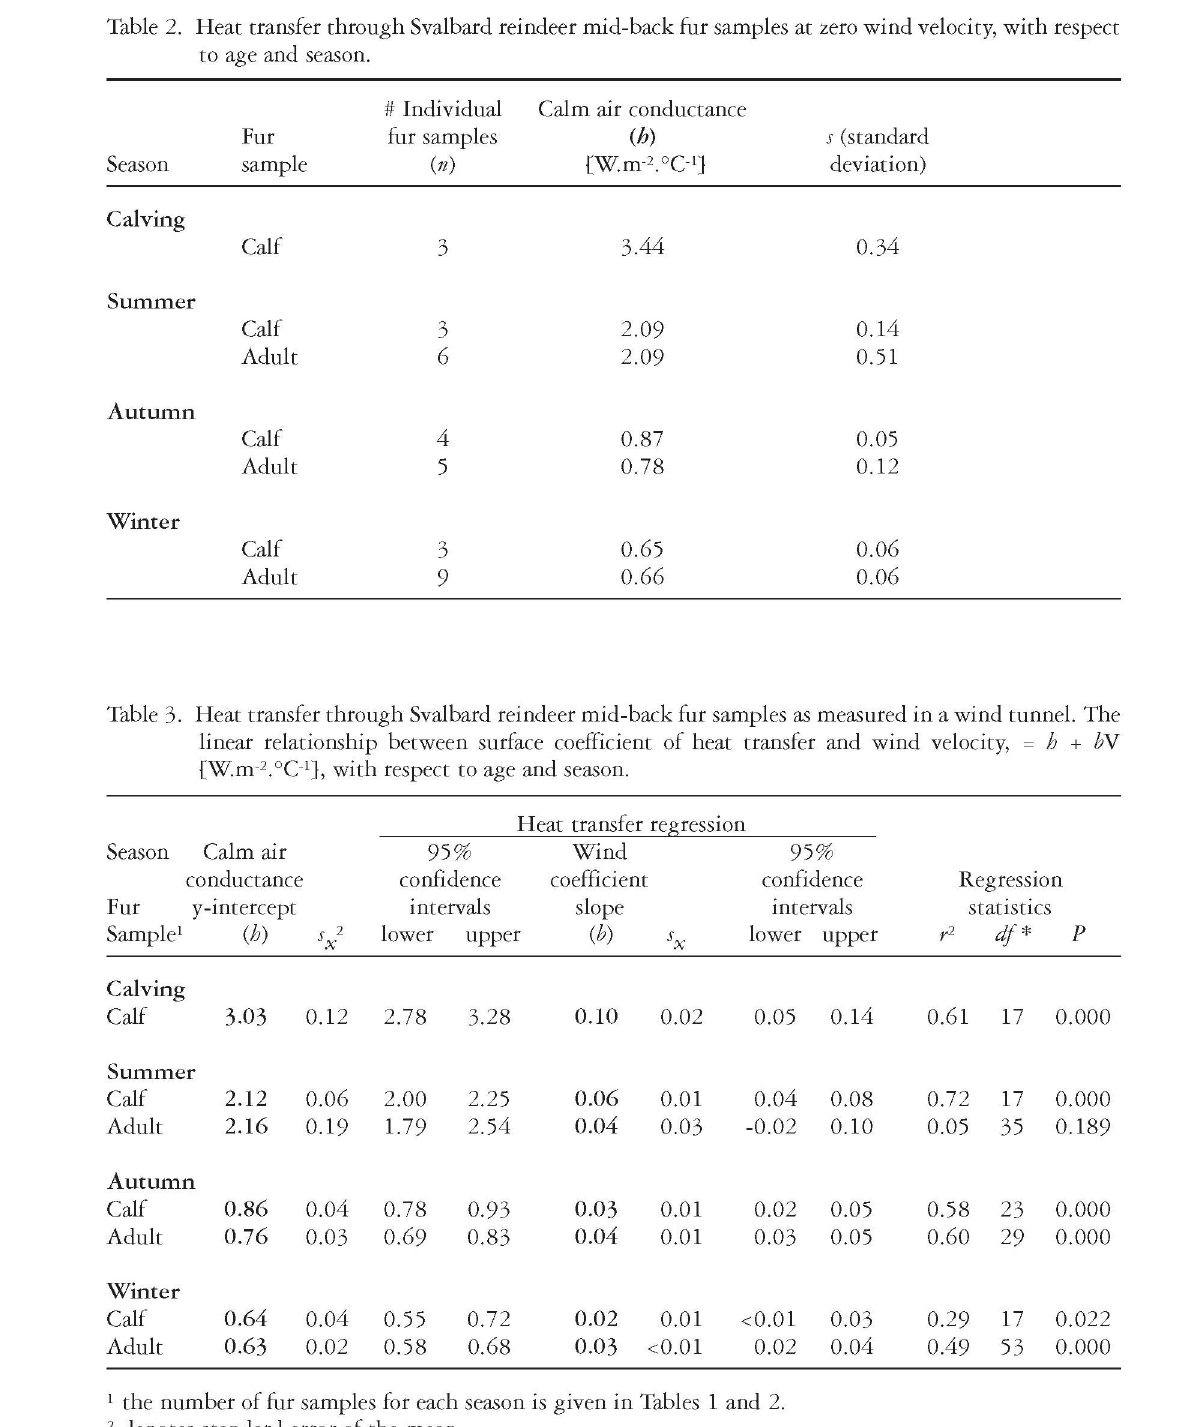
Table 3. Heat transfer through Svalbard reindeer mid-back fur samples as measured in a wind tunnel. The linear relationship between surface coefficient of heat transfer and wind velocity, = h + bV [W.m -2 .°C -1 ], with respect to age and